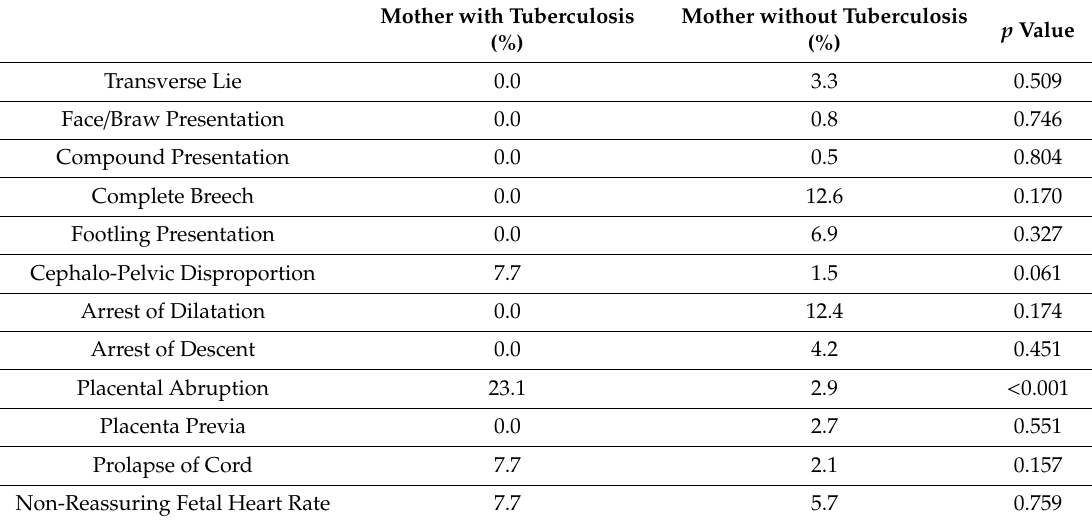
Table 3. Operative indications of women with and without tuberculosis